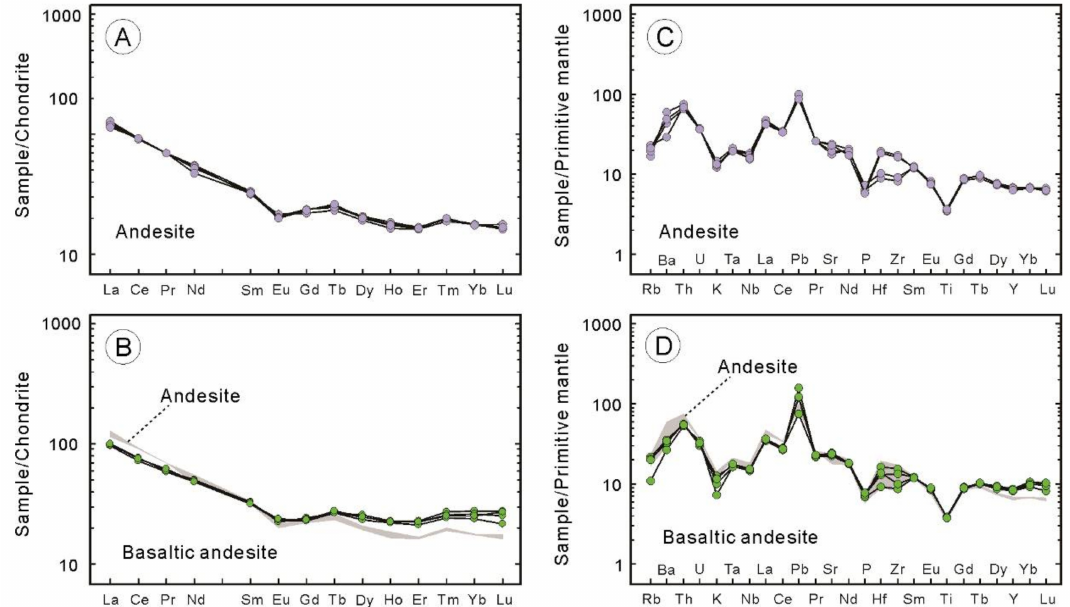
Figure 6. ( A , B ) Whole-rock chondrite-normalized rare earth element (REE) patterns and ( C , D ) primitive-mantle-normalized multi-elements plots for the Nageng andesite and basaltic andesite. Chondrite and primitive Mantle normalizing values are from Ref.